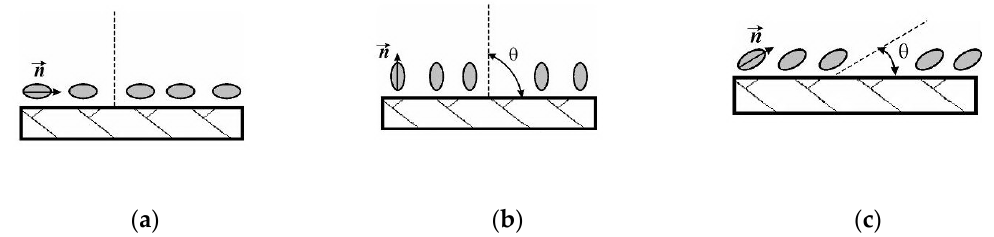
Figure 3. Illustration of the modulated orientation of the LC molecules in the planar ( a ), homeo- tropic ( b ) and tilted ( c ) position.